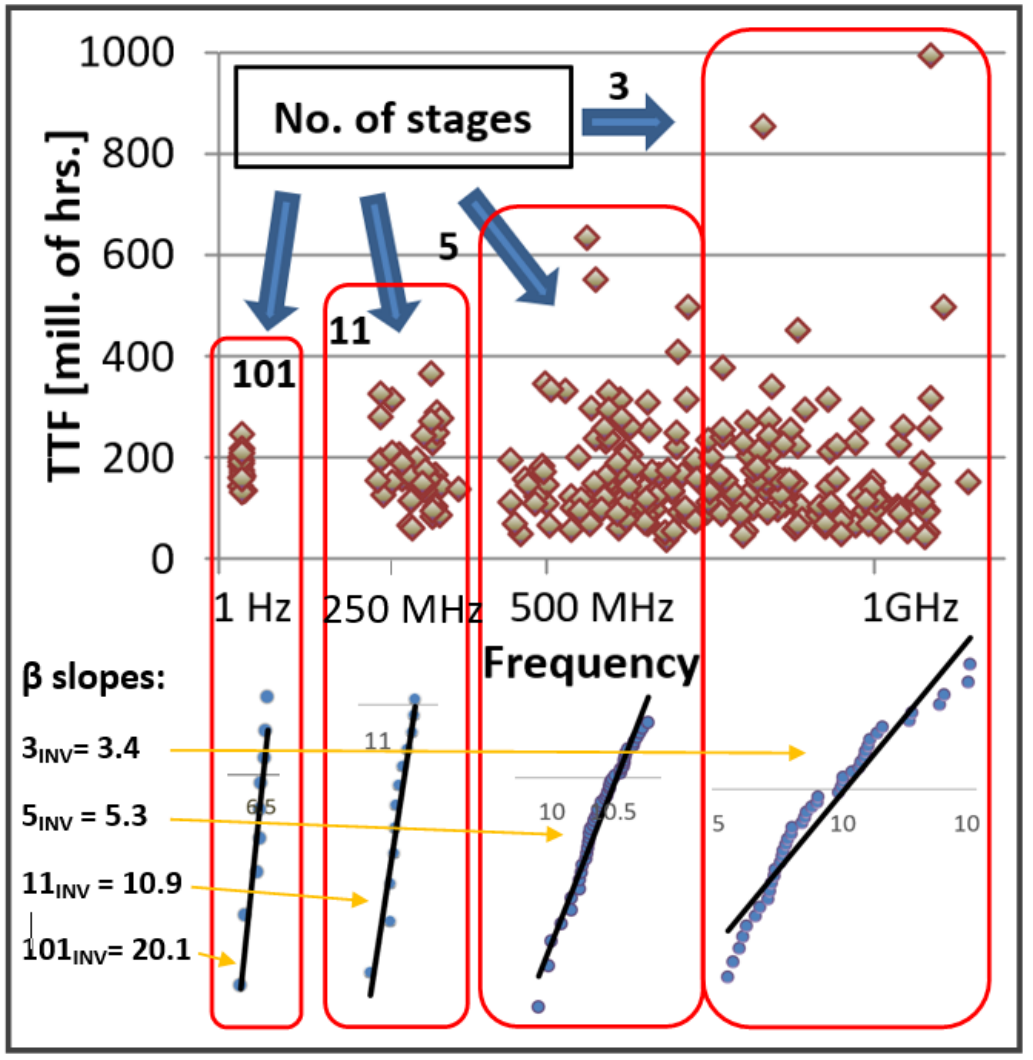
Figure 6. A TTF-to-frequency plot sectioned into four sectors defined by ring sizes of 3, 5, 11, and 101 inverters. The corresponding Weibull plots for the four sectors are displayed below the TTF values for each ring group with their β slope values.